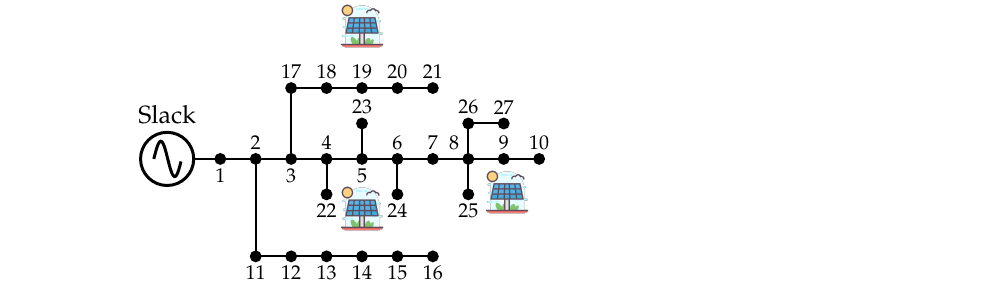
Figure 6. Proposed configuration of the 27-bus grid to simulate the operation scenario in the munici- pality of Capurganá. Table 6. Information regarding peak load conditions, impedance parameters, and current bounds for the 27-bus